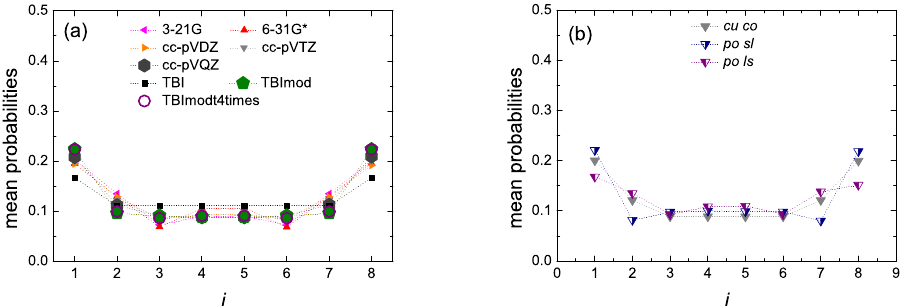
Figure 15. Site occupations, i.e., mean over time probabilities to find the hole at site j , for initial placement of the hole at the first site, for N = 8, obtained by RT-TDDFT [3-21G (pink left triangles), 6-31G* (red up triangles), cc-pVDZ (orange right triangles), cc-pVTZ (gray down triangles), cc-pVQZ (dark gray hexagons)] and functional B3LYP as well as by TB wire model variants [TBI (black squares), TBImod (green pentagons), TBImodt4times (purple circles)]. ( a ) cumulenic molecules with coplanar methylene groups ( cu co ), ( b ) cc-pVTZ/B3LYP for cu co molecules versus polyynic molecules starting with short or long bonds ( po sl or po ls ). Half-filled down triangles correspond to po sl (blue filled right) and po ls (purple filled left). Dotted lines are guides to the